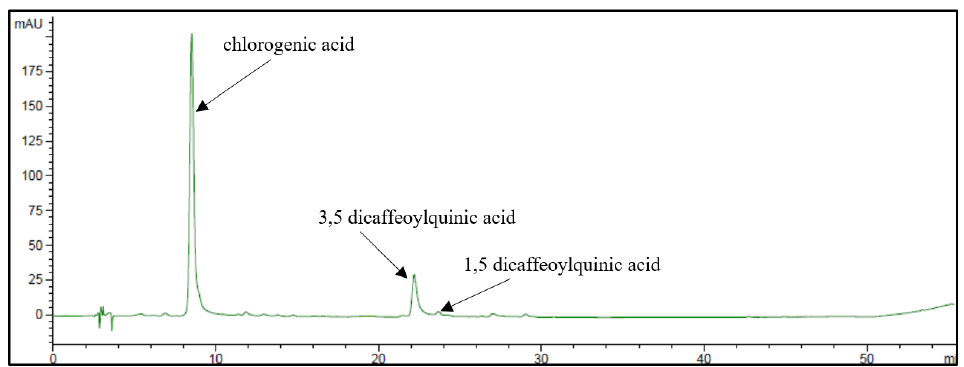
Figure 3. HPLC-DAD chromatogram of phenolic extract obtained from raw golden thistle midribs recorded at 325 nm. Figure 4